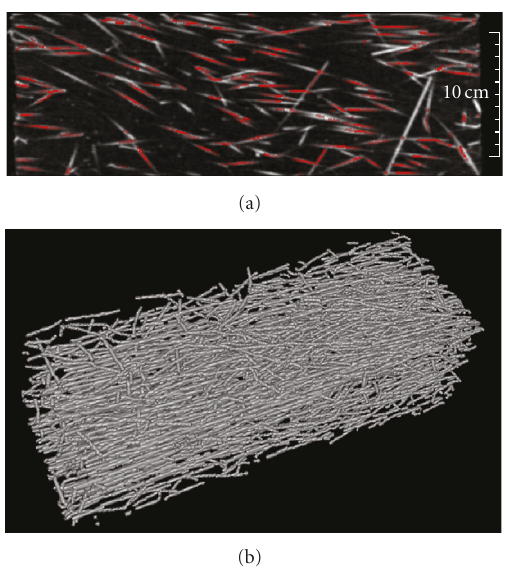
Figure 14: Result of the automatic segmentation algorithm on dataset two. (a) Slice image with the segmentation mask overlaid. (b) 3D view of the extracted fibers. Despite the high curvature of the fibers and the high overlap rate, most of the fibers have been segmented correctly.